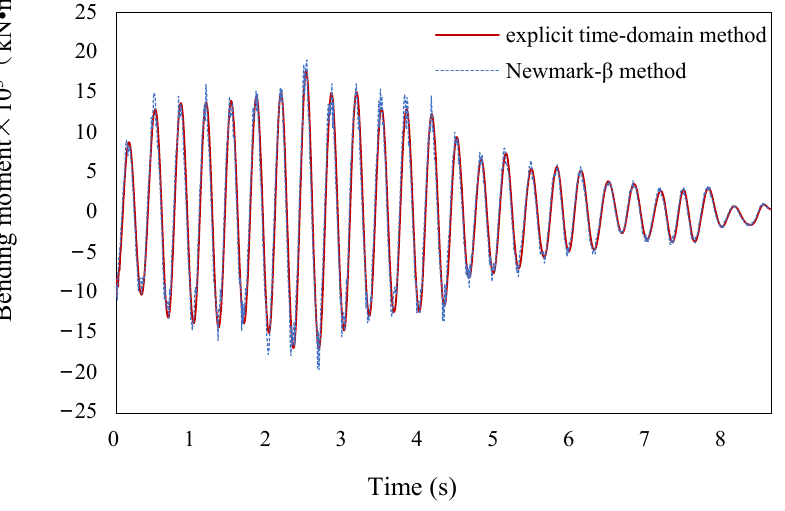
Figure 8. Time-history diagram of the bending moment at the bottom section of P 2.